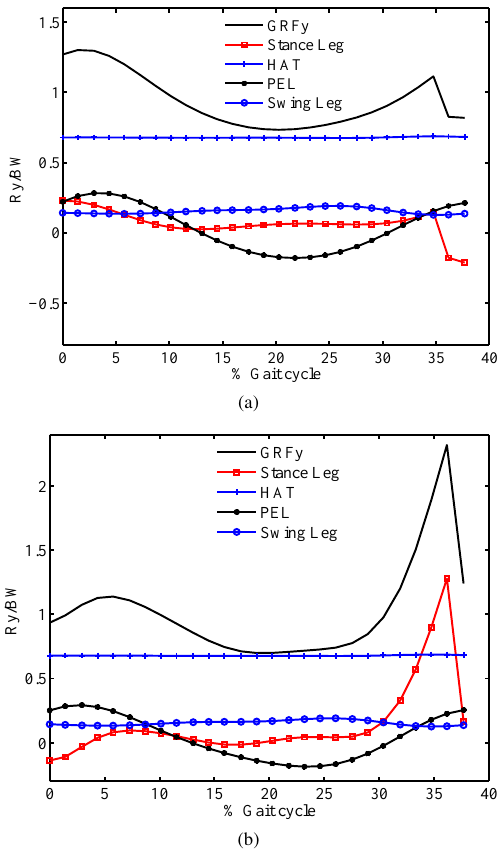
Figure 7. GRFx and stance leg, HAT, pelvis and swing leg contri- butions to GRFx during SS phase as a fraction of body weight with (a) AFROS and (b) FROS. (Gait cycle starts at toe-o ff of the other leg, that is, at the beginning of SS.)